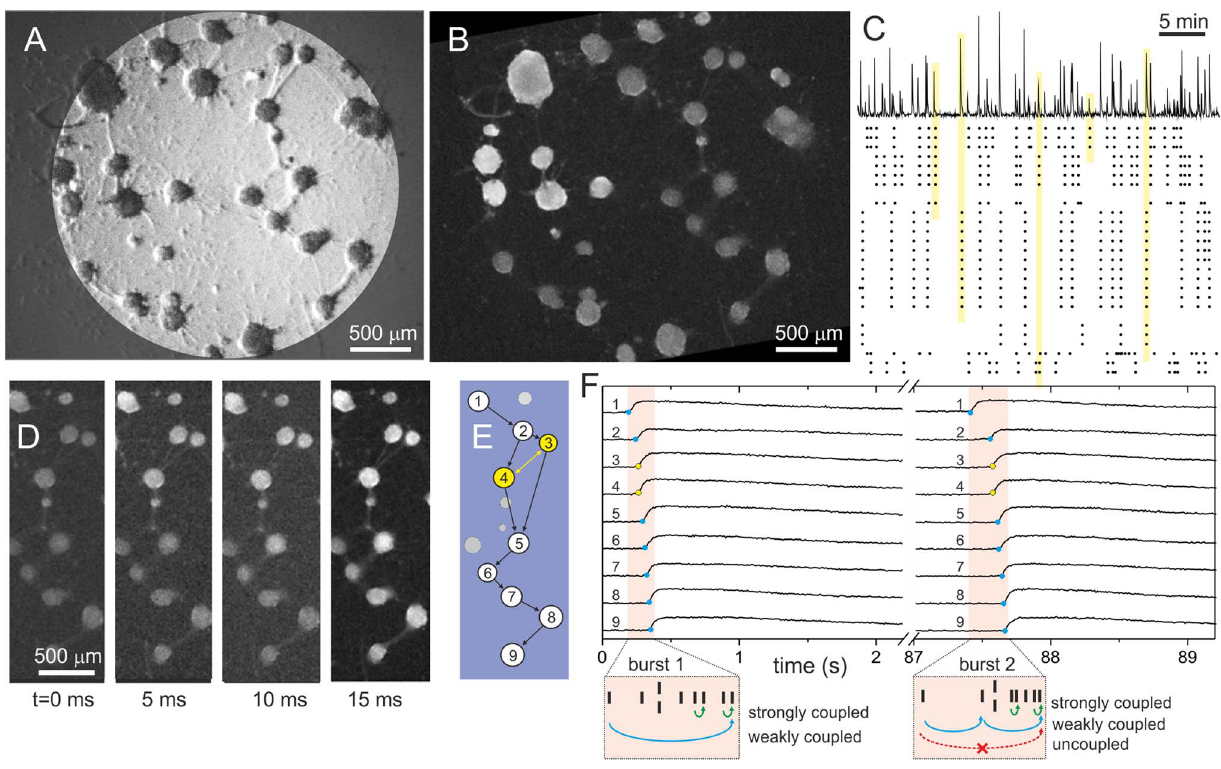
Figure 1. Experiments in clustered neuronal networks. A Bright field image of a network at day in vitro 14 . Dark circular objects are aggregates of neurons (clusters), and filaments are visible physical connections between them. B Corresponding fluorescence image, integrated over 50 frames ( & 0 : 5s ). Bright clusters at the top-left corner are active ones. C Spontaneous activity in the network (see Movie S1 for the actual recording). The top plot shows the average fluorescence signal of the clustered network shown in B , and along 40min of recording. The sharp peaks in fluorescence correspond to the fast sequential ignition of a group of clusters (burst). The bottom raster plot shows the clusters that ignite along the recording. The yellow bars relate a fluorescence peak with the ignition of a group of clusters, and highlights the tendency for the clusters to activate in specific groups. D Example of a particular ignition sequence in a region of the network containing 13 clusters. From left to right, the progress of cluster’s activation is revealed by the increase in fluorescence signal of the downstream connected clusters. E Order of activation (black arrows) according to the analysis of the fluorescence signal. The clusters marked in yellow are those that fire simultaneously within experimental resolution. The ones in grey are clusters that do not participate in the firing sequence, and either fire independently or remain silent. F Detail of the fluorescence traces for the 9 participating clusters along two consecutive bursts, illustrating the accuracy in resolving the time delay in the activation of the clusters. The two bursts contain the same clusters, but the activation sequences are slightly different. Blue dots mark the ignition time, and yellow dots signal the clusters that fired simultaneously. The bottom orange boxes depict the final activation sequences of each burst. In the construction of the directed functional network, the influence of a cluster on another is conditioned by the time span between their activations. Close activations result in strong couplings (green arrows); far activations in weak ones (blue). Any two clusters whose activations are above 200 ms are considered functionally uncoupled